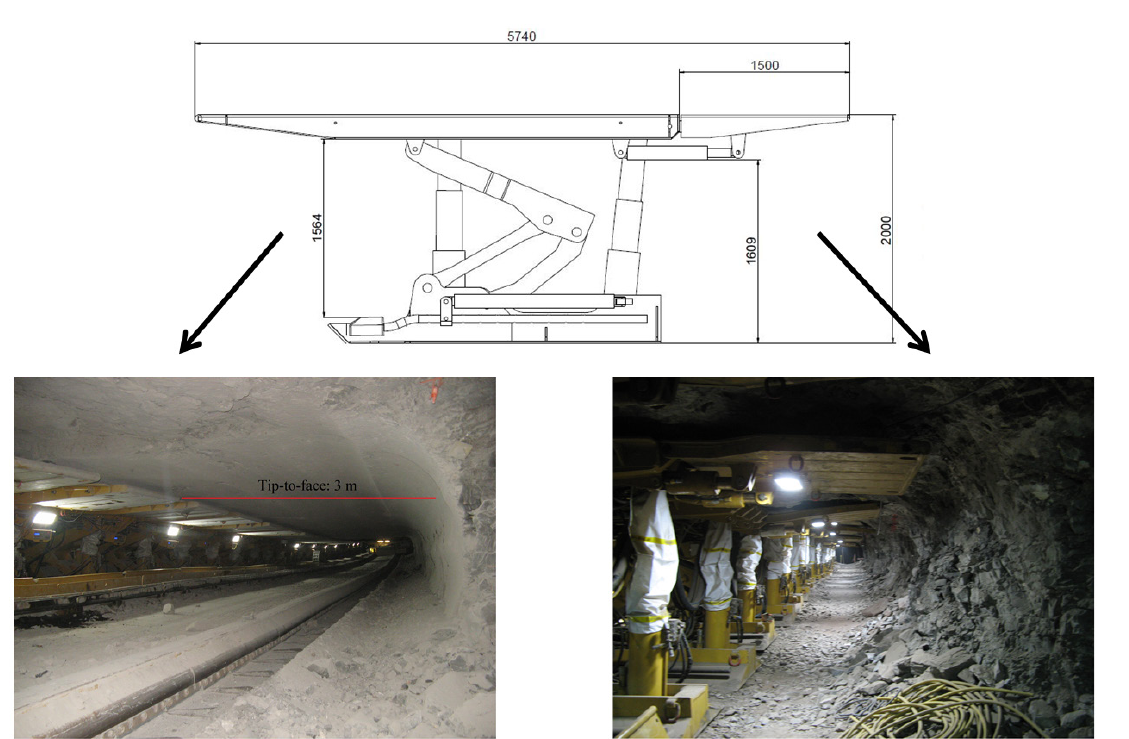
Figure 5: Outline of the powered roof support applied in the 5A/1 longwall panel at the set-up